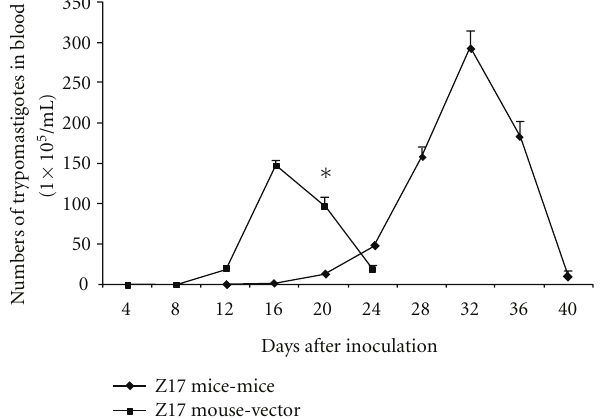
Figure 2: Parasitemia curve of strain Z17 (mouse-mouse versus triatoma-mouse). ∗ P value < 0.05 in comparison between both